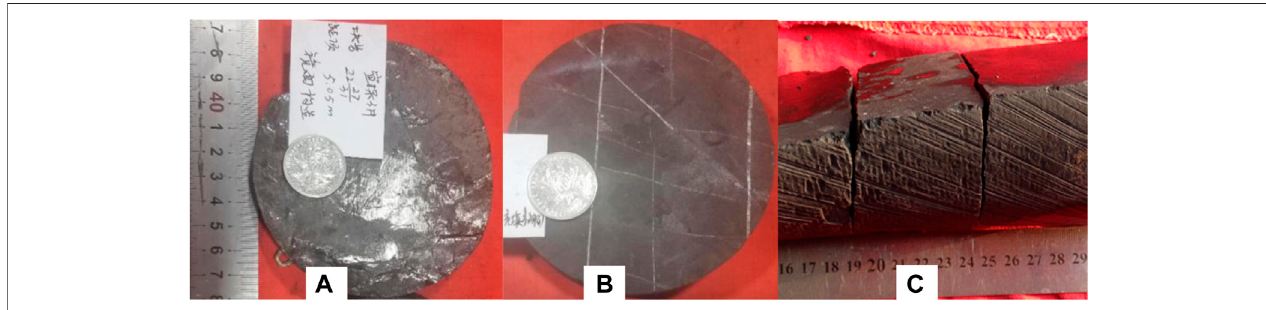
FIGURE8 | Characteristics ofstructuralfractures in Indosinianperiod (A,B) and early Yanshanianperiod (C) . (A) Mirror structure (L114); (B) conjugate shear joints (L112); (C) High angle natural fractures (L112, see mirror structure).